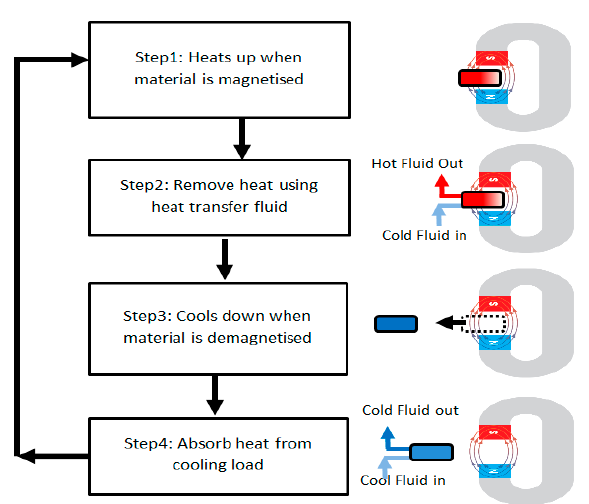
Figure 1. Schematic showing the basic working principle of Magnetic Refrigeration.